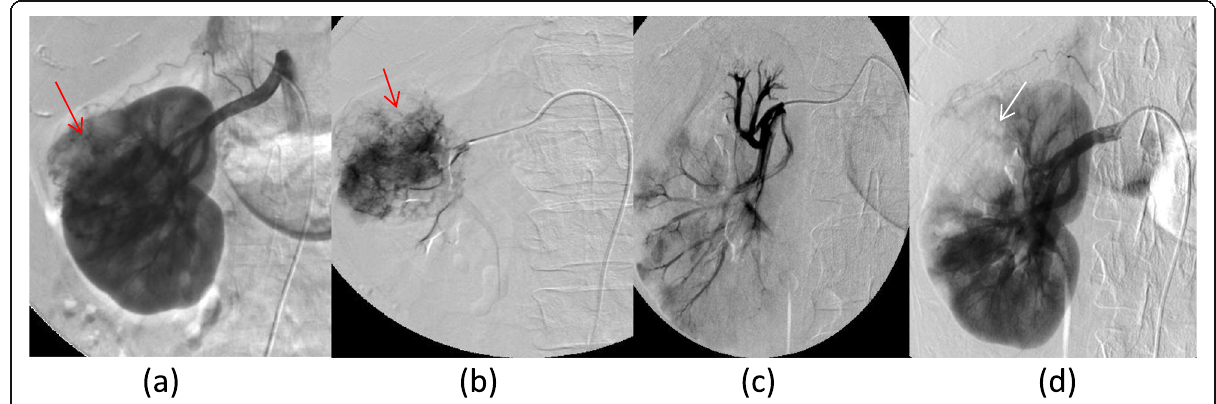
Fig. 8 A 38-year-old man had persistent hematuria due to an angiomylipoma of the right kidney. Renal artery angiography with the Cobra catheter at the origin ( a ) shows the tumor in the middle zone (red arrow). Microcatheter angiography defines the segmental branch feeding the tumor ( b ). PVA was injected through the microcatheter with obliteration of the tumor bed as seen in the post-embolization micro-catheter angiography. Main renal angiography showed disappearance of the tumor with sparing the renal arterial tree (white arrow) ( d